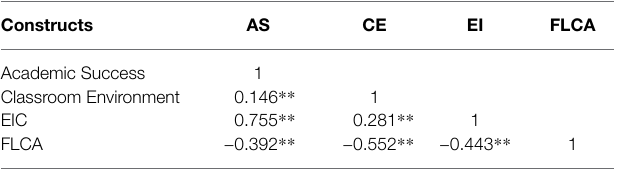
TABLE 3 | Correlation analyses. TABLE 1 | Measurement